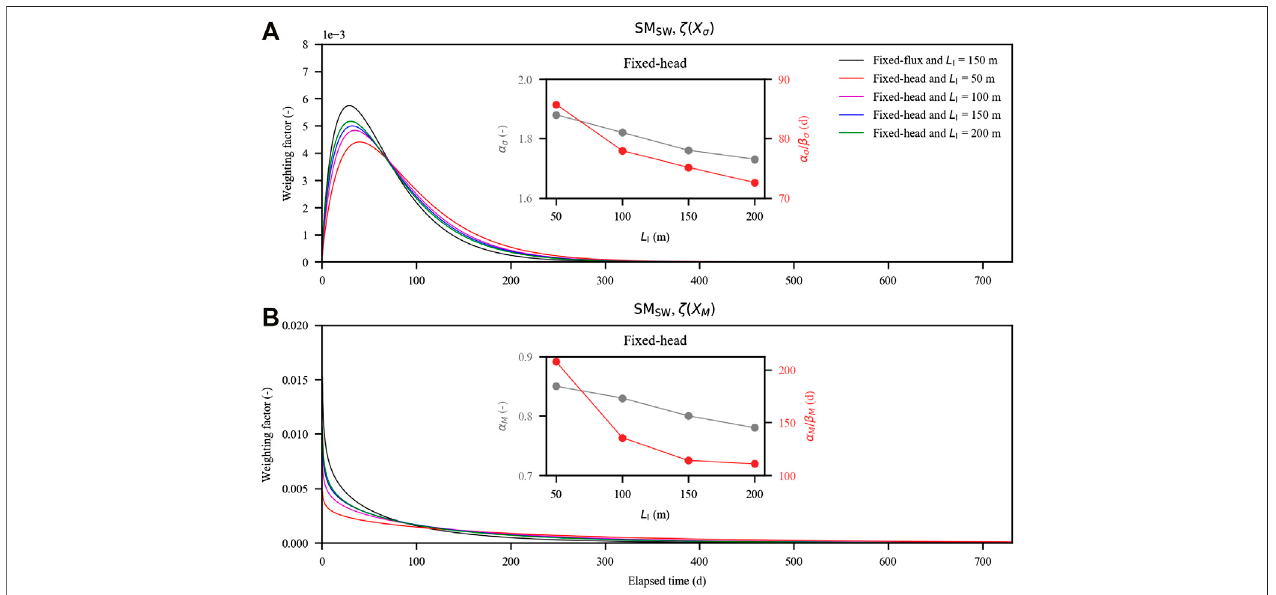
FIGURE 9 | Probability density functions of the amount of salt stored in the saltwater wedge (SM SW ) quanti fi ed with the antecedent tidal conditions on the aquifer: (A) time-dependent weighting factor for the standard deviation of tidal level ( X σ ) and (B) time-dependent weighting factor for the averaged tidal level ( X M ). For the cases with fi xed-head inland boundaries, the shape and mean parameters ( α and α / β ) of the Gamma distribution functions are given in the inserts.